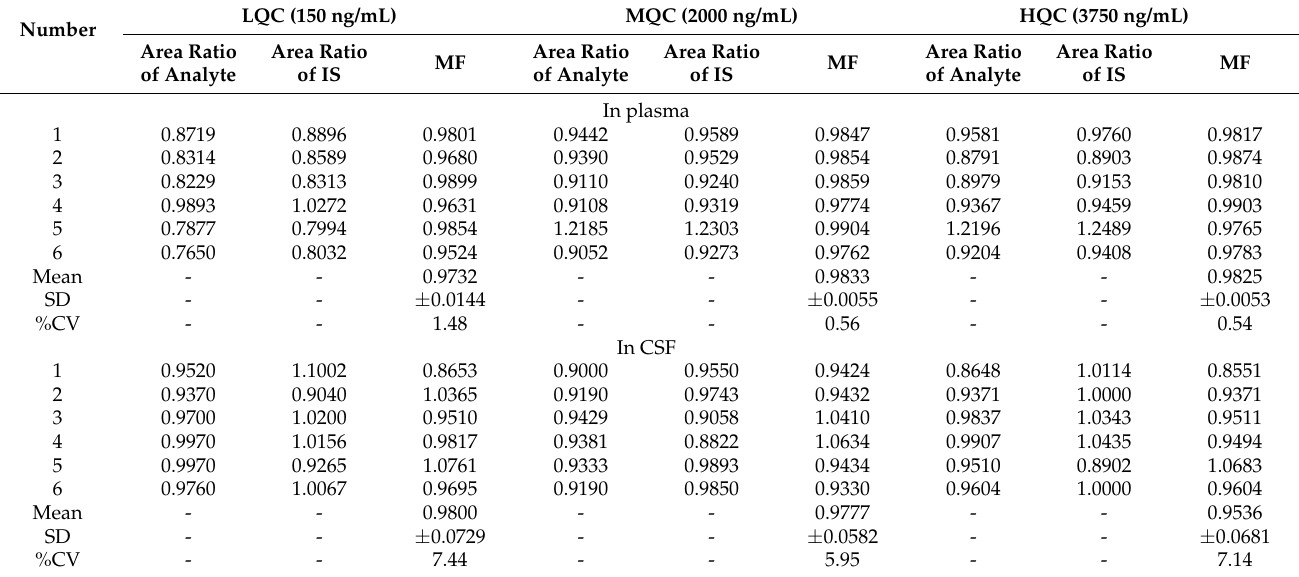
Table 5. ME and matrix factor of the method for determining contezolid and linezolid in six individ- ual